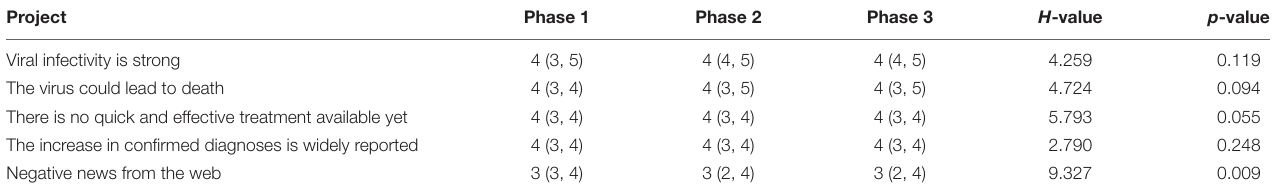
TABLE 5 | The Kruskal–Wallis H test scores of college students’ identification with the source of fear in three stages of the pandemic [Points, M (P25, P75)]. Project